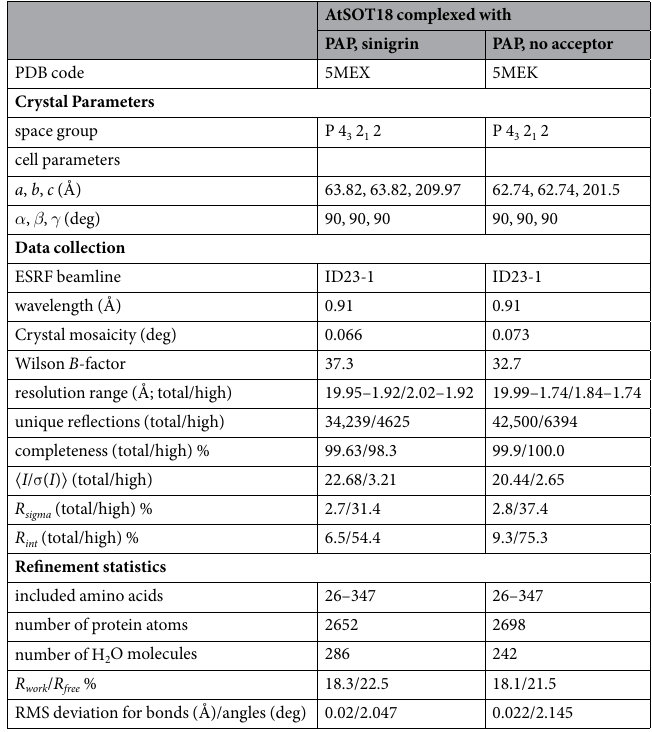
Table 2. Crystallographic data and refinement statistics for the AtSOT18 • PAP • sinigrin and the AtSOT18 • PAP complexes. Information on high-resolution data referred to the outer 0.1 Å of the resolution